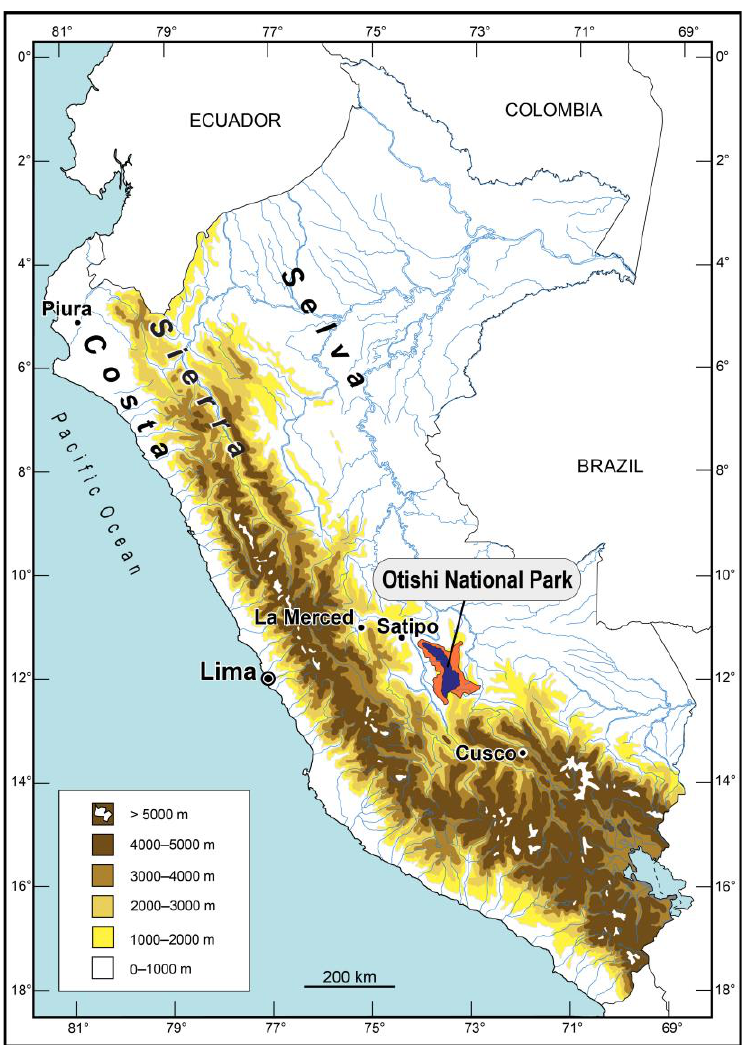
Figure 1. Peru with the Otishi National Park in dark blue, the Asháninka Communal Reserve on its west side (in pink), and the Machiguenga Communal Reserve on its east side (in pink). In 1963, the vast unexplored territory of the Cordillera de Vilcabamba attracted at- tention. The Zoological Society of New York and the National Geographic Society funded a research expedition to explore this area. A team of researchers used parachutes to reach high elevations near the Laguna Parodi and walked adventurously a 150-mile trek by foot northwards down to the Urubamba River in the Amazonian lowlands [2]. In 1997 and 1998, the Smithsonian Institution/Monitoring and Assessment Biodiversity Program team of botanists, zoologists, and anthropologists conducted rapid program assessment sur- veys at six sites in the northern and southern Cordillera de Vilcabamba [3], two of which (Camp 1 and Camp 2) are today located inside ONP (Figure 2). A detailed report was published in 2001 which documented the rich biodiversity and mentioned several new species [3] some of which were later described (e.g., Lehr 2007 [4]: Pristimantis seorsus , P. vilcabambae , and P. tanyrhynchus ; Mendoza 2005 [5]: Polylepis canoi ; Mamani and Rodríguez 2022 [6]: Proctoporus otishi from Camp 1). The creation of ONP followed in 2003, and its recognition as an UNESCO Biosphere Reserve in 2021 [7]. Instituto Nacional de Rercursos Naturales (INRENA) [7] mentions that 11 species of amphibians and six species of reptiles (two lizards, five snakes) were recorded within ONP, but without details on their identifications or localities. Lack of knowledge regarding the biodiversity of the Cor- dillera de Vilcabamba has also been recognized by Rodríguez and Young [8], and Fajardo